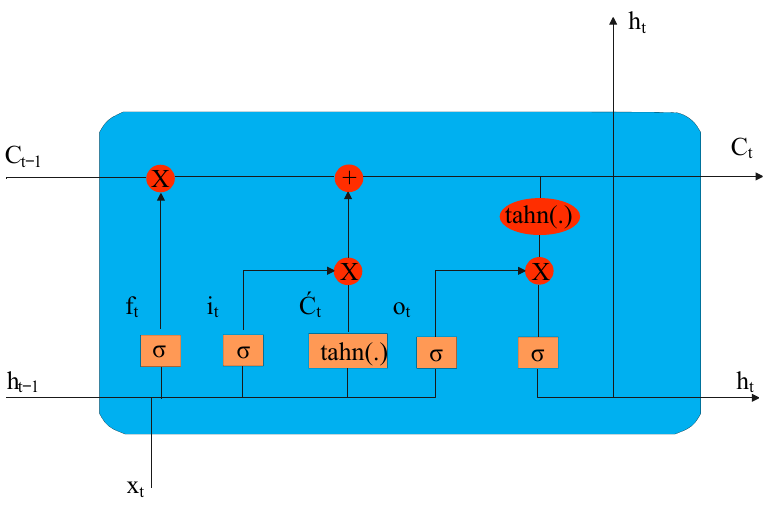
Figure 6. Typical LSTM network